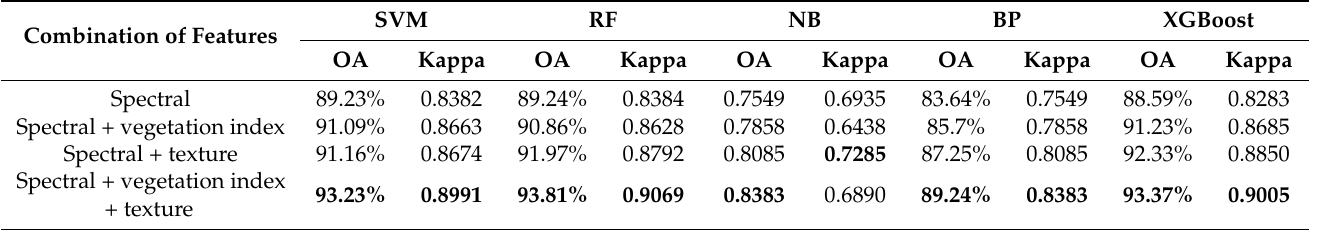
Table 7. OA and Kappa coefficients using different classifiers and a combination of image features.